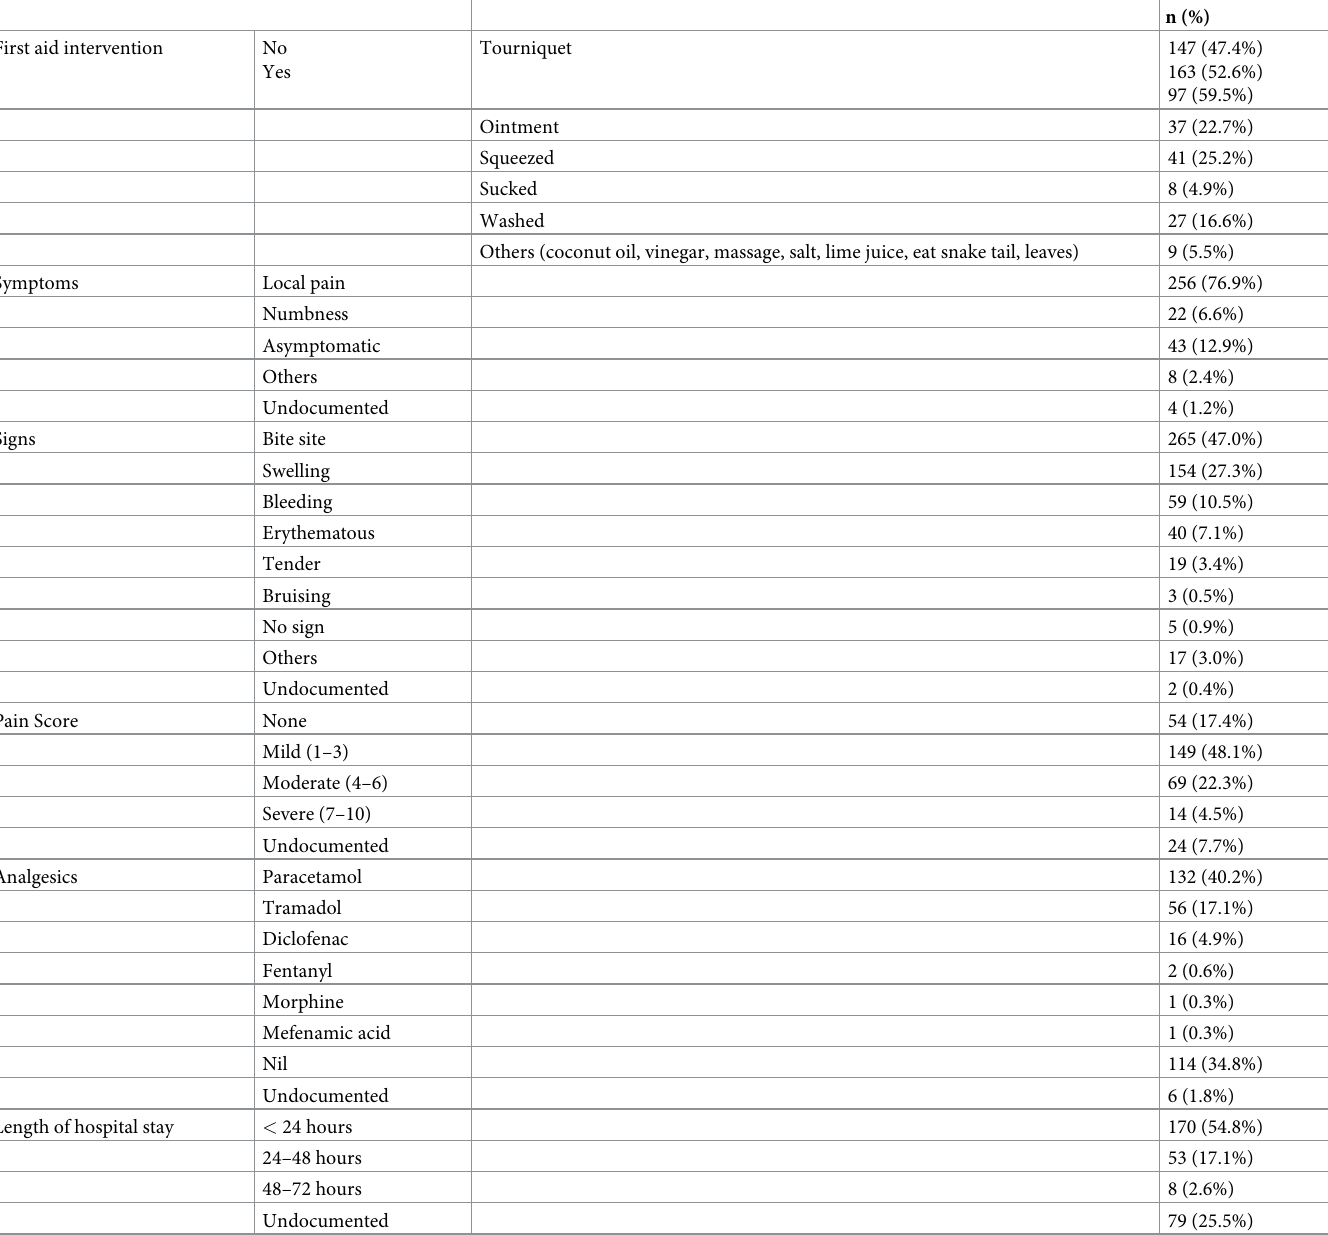
Table 2. The clinical presentation, management and outcome of Tropidolaemus spp . bite consulted to RECS from